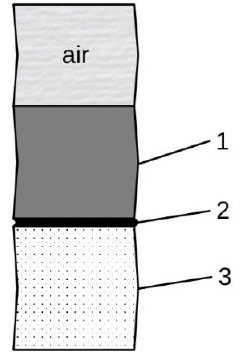
Fig. 7. Scheme of layers of Mergui’s heating wall. 1 copper sheet, 2 heater, 3 thermal